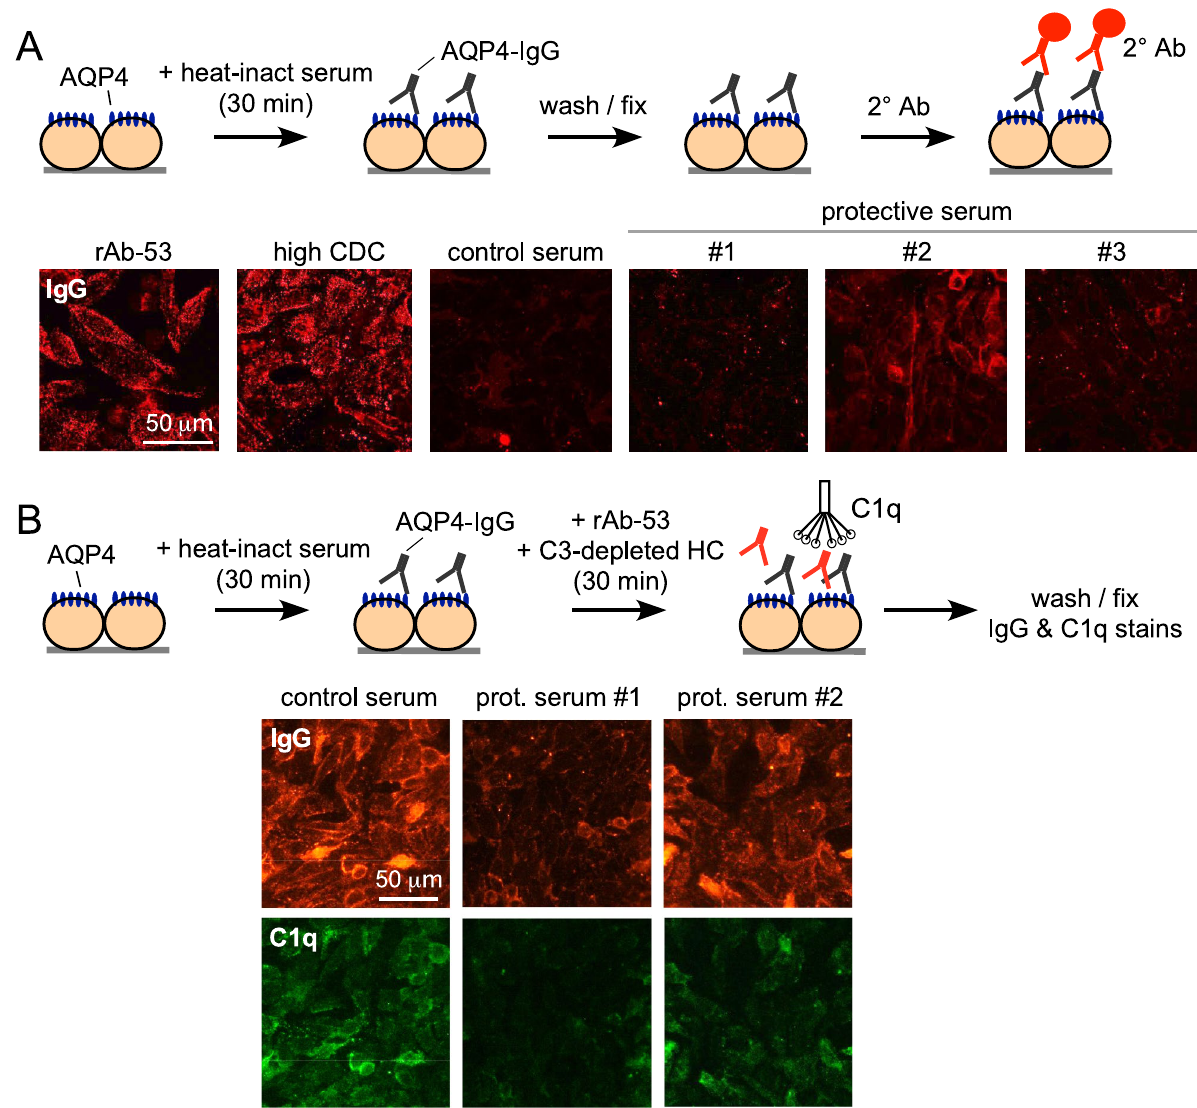
Figure 4. Cytoprotective sera reduces binding of pathogenic AQP4-IgG and C1q at the cell surface. ( A ) Cytoprotective serum binding study. AQP4-expressing CHO cells were incubated with 10% heat-inactivated cytoprotective or control sera (or 5 µg/ml rAb-53), followed by fluorescent anti-human IgG secondary antibody. ( B ) C1q and pathogenic AQP4-IgG (rAb-53) binding. AQP4-expressing CHO cells were incubated with heat-inactivated cytoprotective or control sera followed by 1 µg/ml rAb-53 and 10% C3-deficient human complement, and then stained for human IgG (red) and C1q